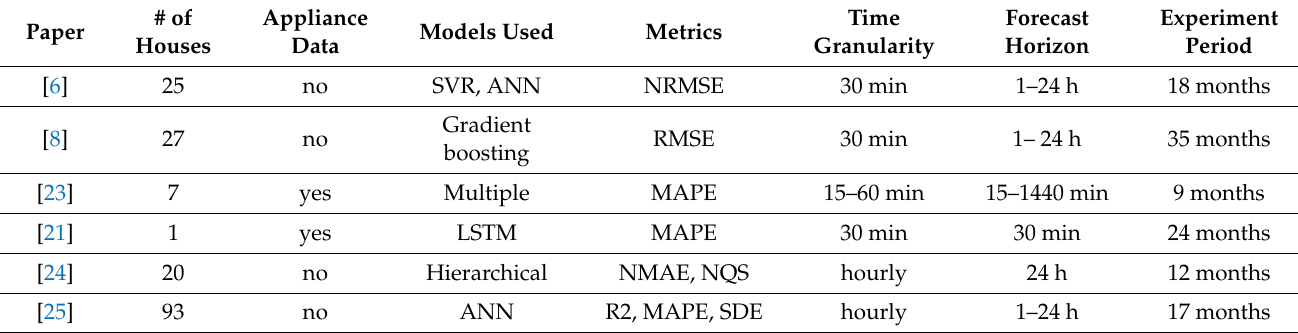
Table 1. Related studies regarding residential consumption